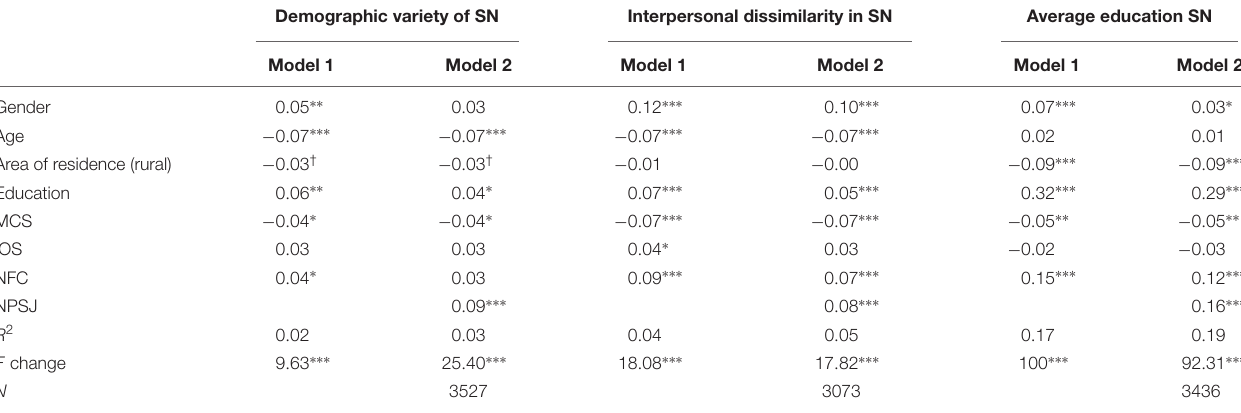
TABLE 2 | Results of the OLS regression